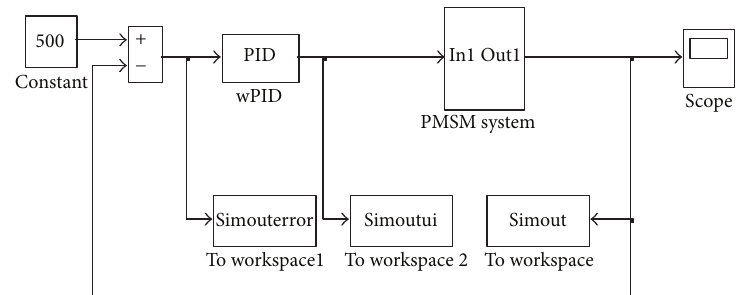
Figure 12: The diagram of PMSM control system.